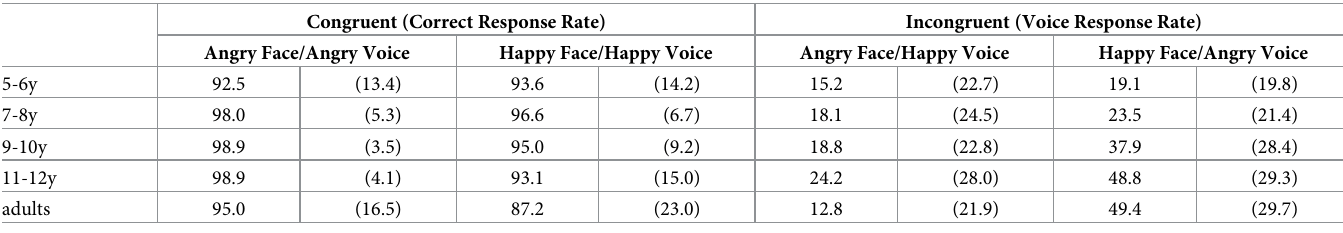
Table 1. Average performances in the emotion perception task